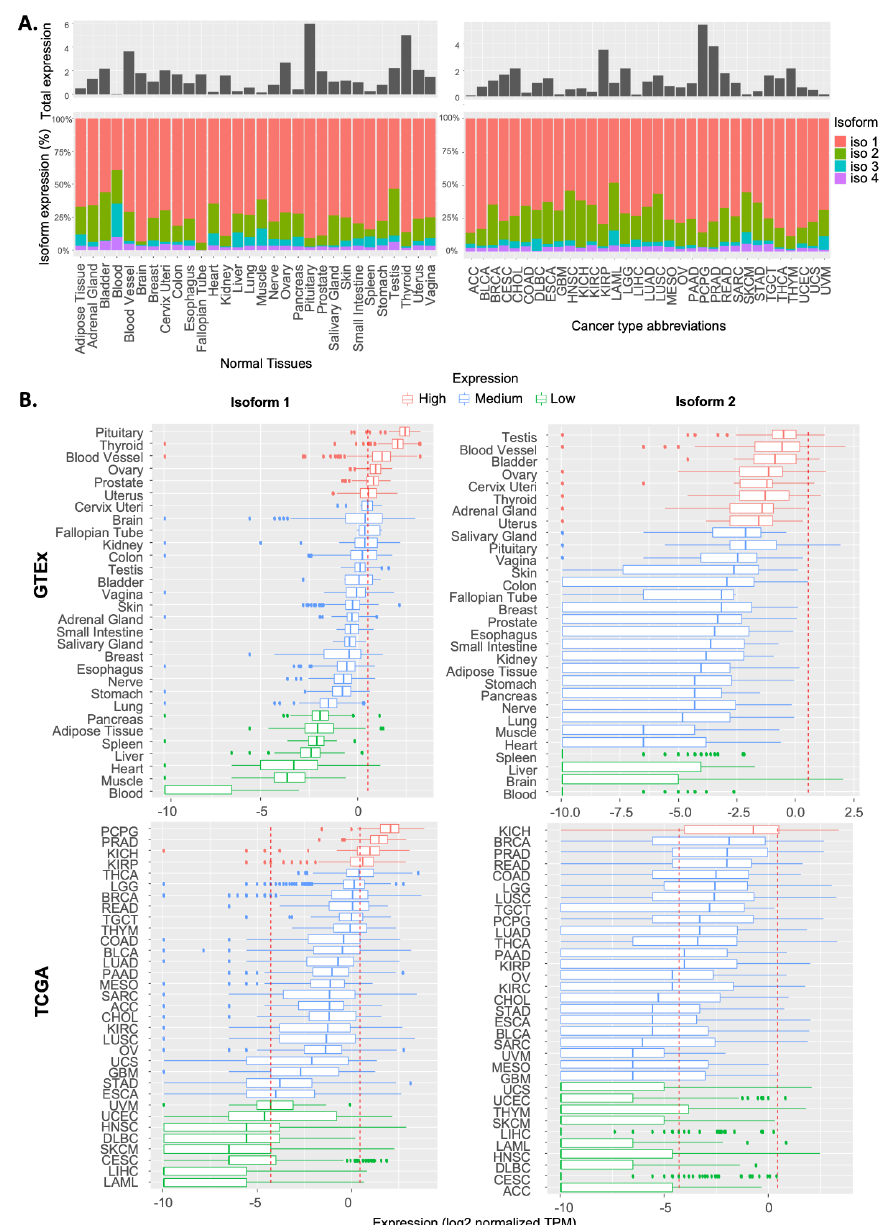
Figure 1. Expression of RSK4 transcripts in normal and cancer tissues. ( A ) Top: Histogram showing total RSK4 expression across normal (GTEx) (left) and cancerous (TCGA) (right) tissues. Bottom: Stacked bar plot illustrating the relative expression of the four transcript isoforms of RSK4. Tumour type abbreviations are decoded in Supplementary Table S1. ( B ) Boxplots showing the distribution of isoform 1 (left) and 2 (right) expressions among different normal tissues (top) and cancer types (bottom). Dotted lines mark the 25% and 75% quantiles used to categorise tissues into high (red), medium (blue), and low (green)